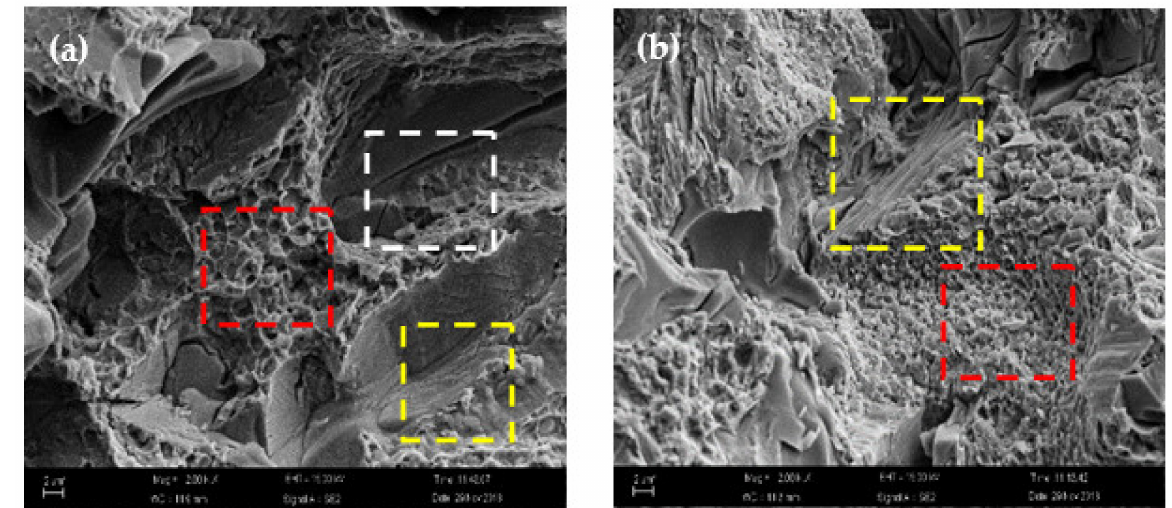
Figure 9. Fracture morphology of MoNbTaWTi Arc Surfacing layer after compressive deformation at high temperatures: ( a ) T = 500 ◦ C and ( b ) T = 1000 ◦